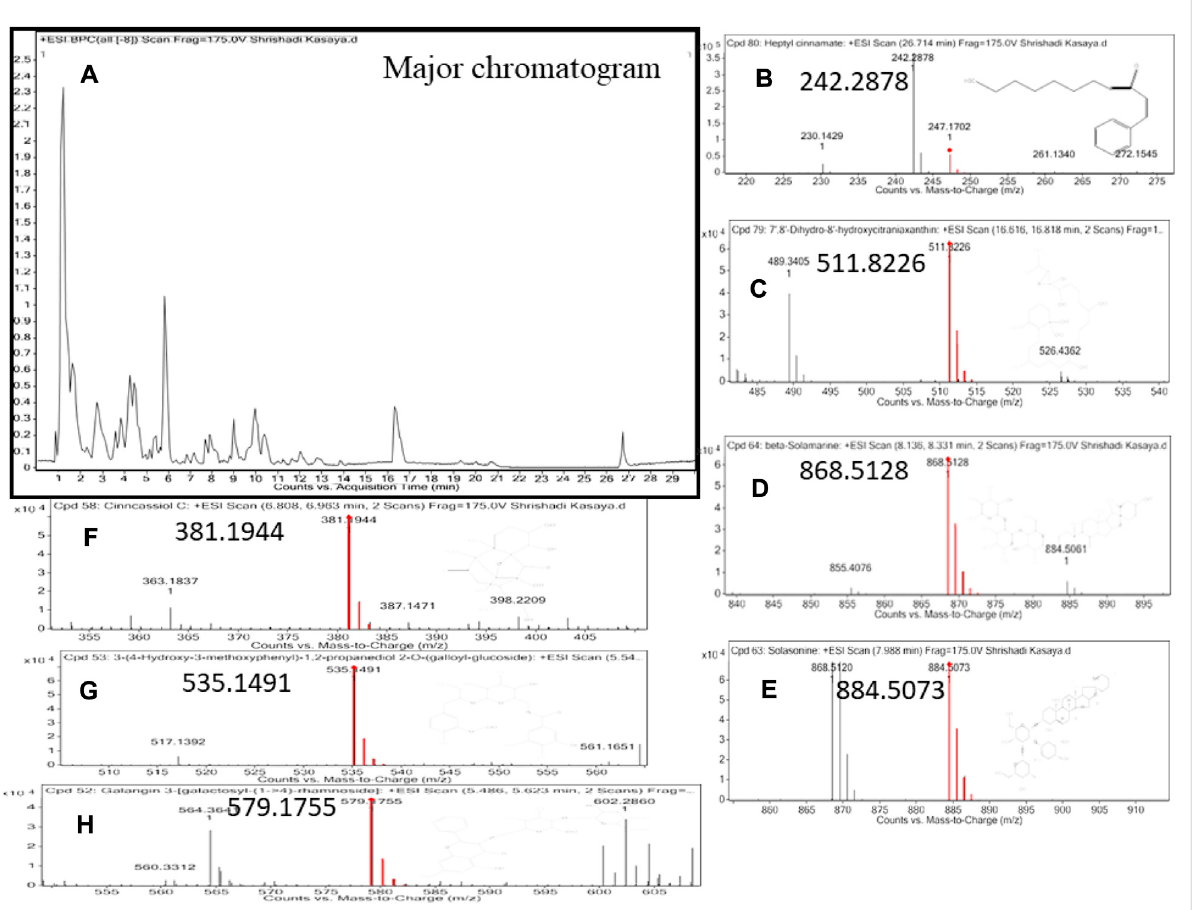
FIGURE 3 High-resolution liquid chromatography-mass spectroscopy of Bronco T showing the Major chromatogram (A) and the identi fi ed phytoconstituent with the highest retention time, which is active againstrespiratory disorders (B) :heptyl cinnamate, (C) 7 ′ , 8 ′ -dihydro-8 ′ -hydroxycitraniaxanthin, (D) beta-solamarine, (E) Solasonine, (F) Cinncassiol C, (G) 3- (4-hydroxy-3-methoxyphenyl) -1,2-propanediol 2-O- (gallolyl-glucoside), (H) Galangin 3- [galactosyl- (1- >